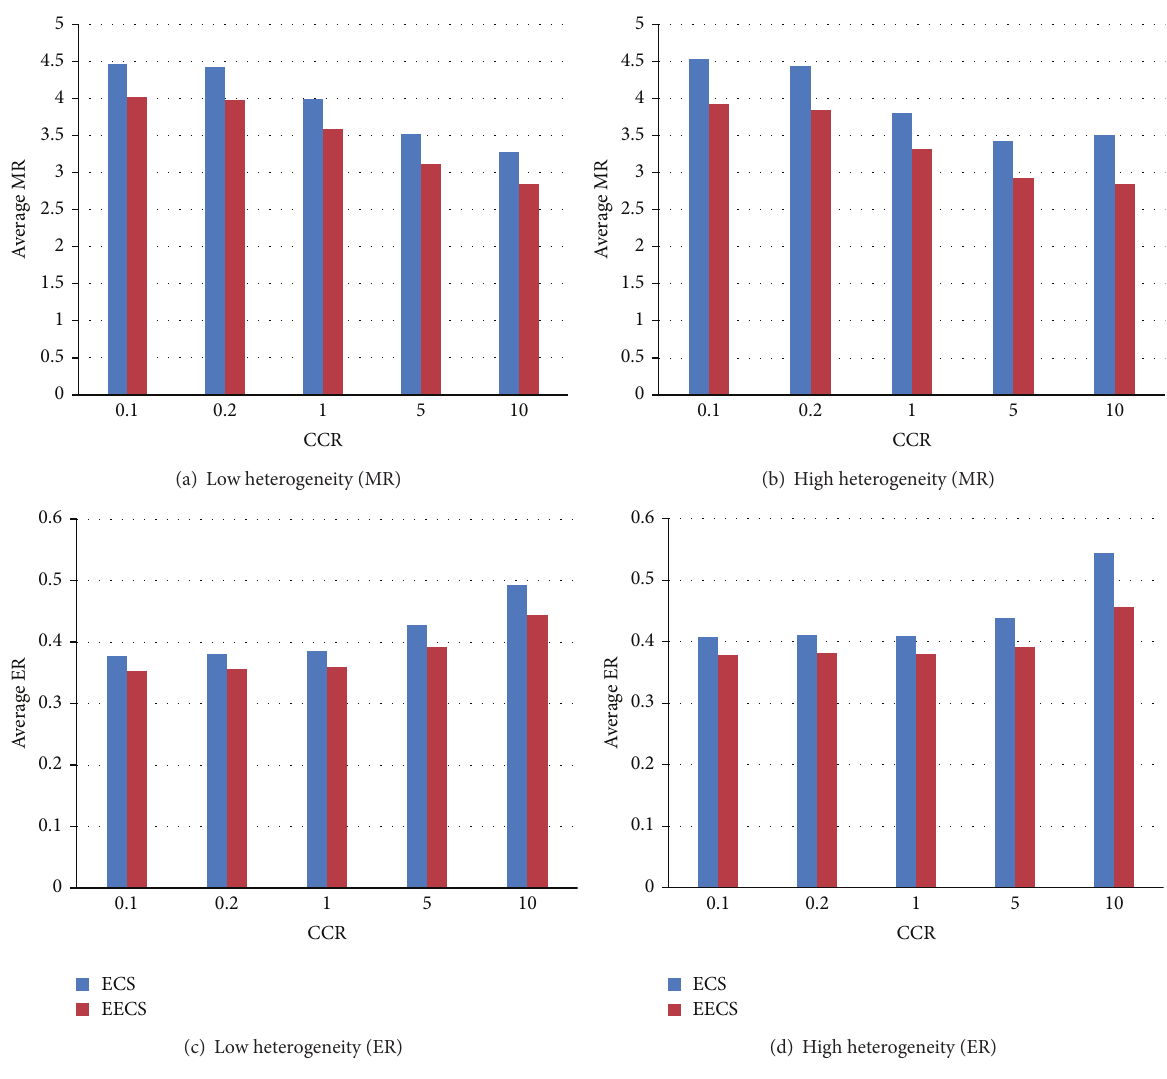
Figure 5: LIGO, 77 nodes (different heterogeneities of processors).